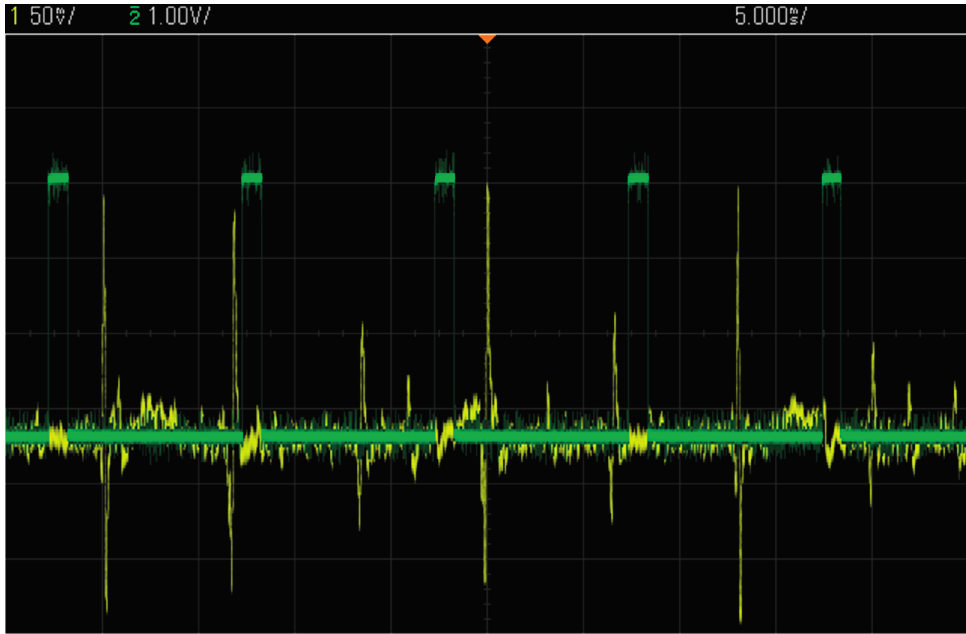
Figure 9. 150 µV peak-to-peak spike waveforms at the AFE output along with the stimulation pattern at one LED terminal, both acquired with an